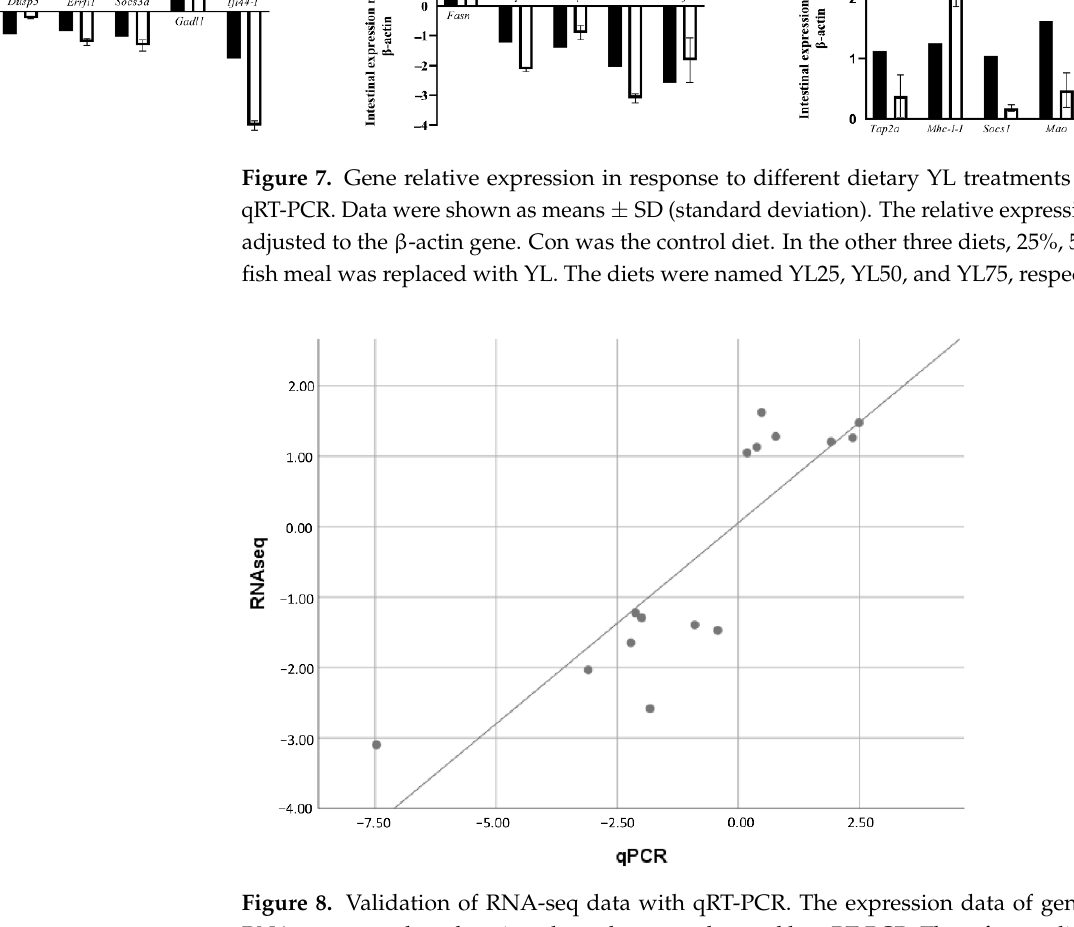
Figure 8. Validation of RNA-seq data with qRT-PCR. The expression data of genes detected by RNA-seq were plotted against those that were detected by qRT-PCR. The reference line indicates the linear correlation between the RNA-seq and qRT-PCR.